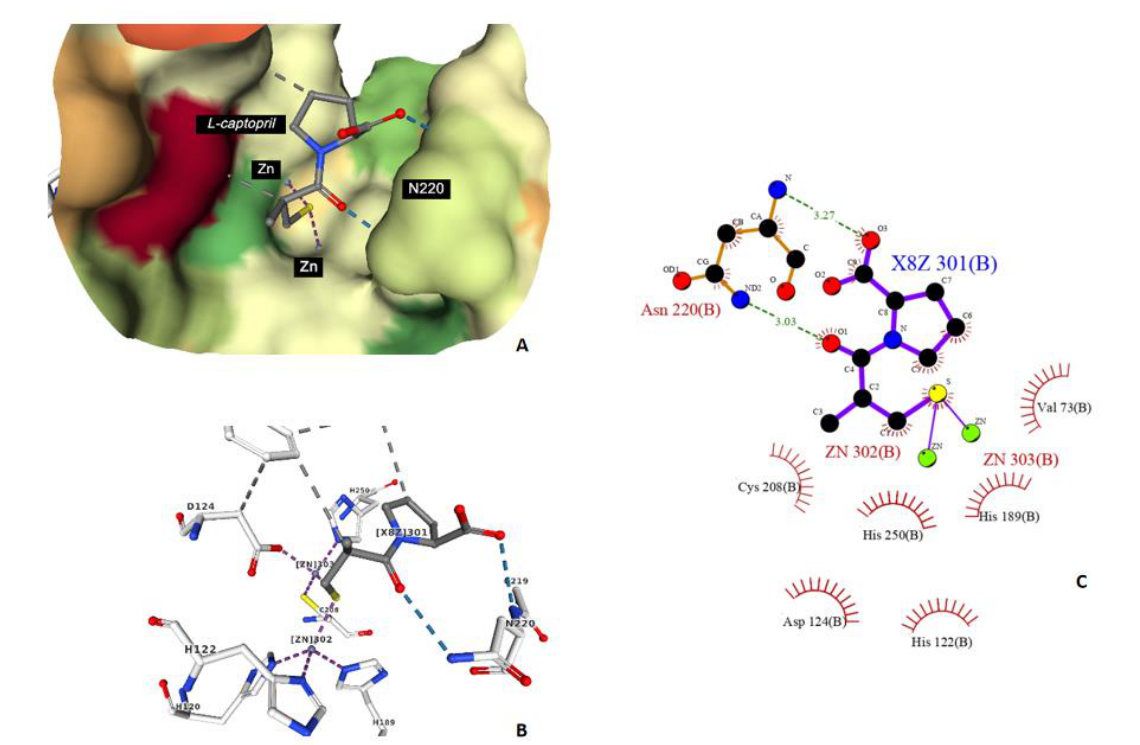
Figure 9: The binding modality of L - captopril against the active site of NDM-1 (PDB ID: 4EXS) ( A and B ) and 2D interaction diagram generated by Ligplot+ ( C ), the carbonyl groups act as hydrogen bond acceptor with Asn220 to facilitate the pocket formation.